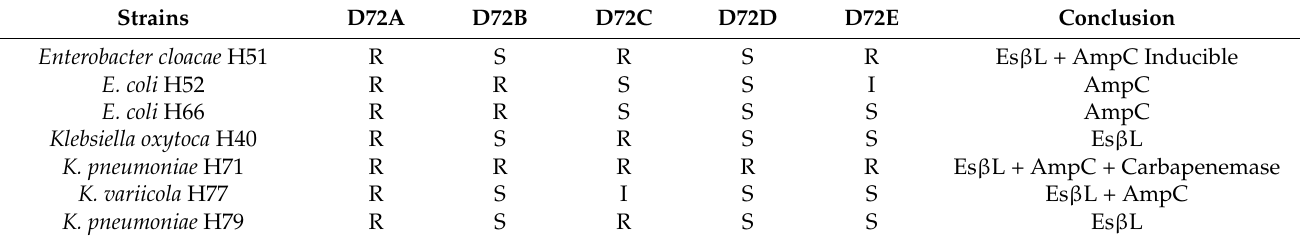
Table 1. Beta-lactamase